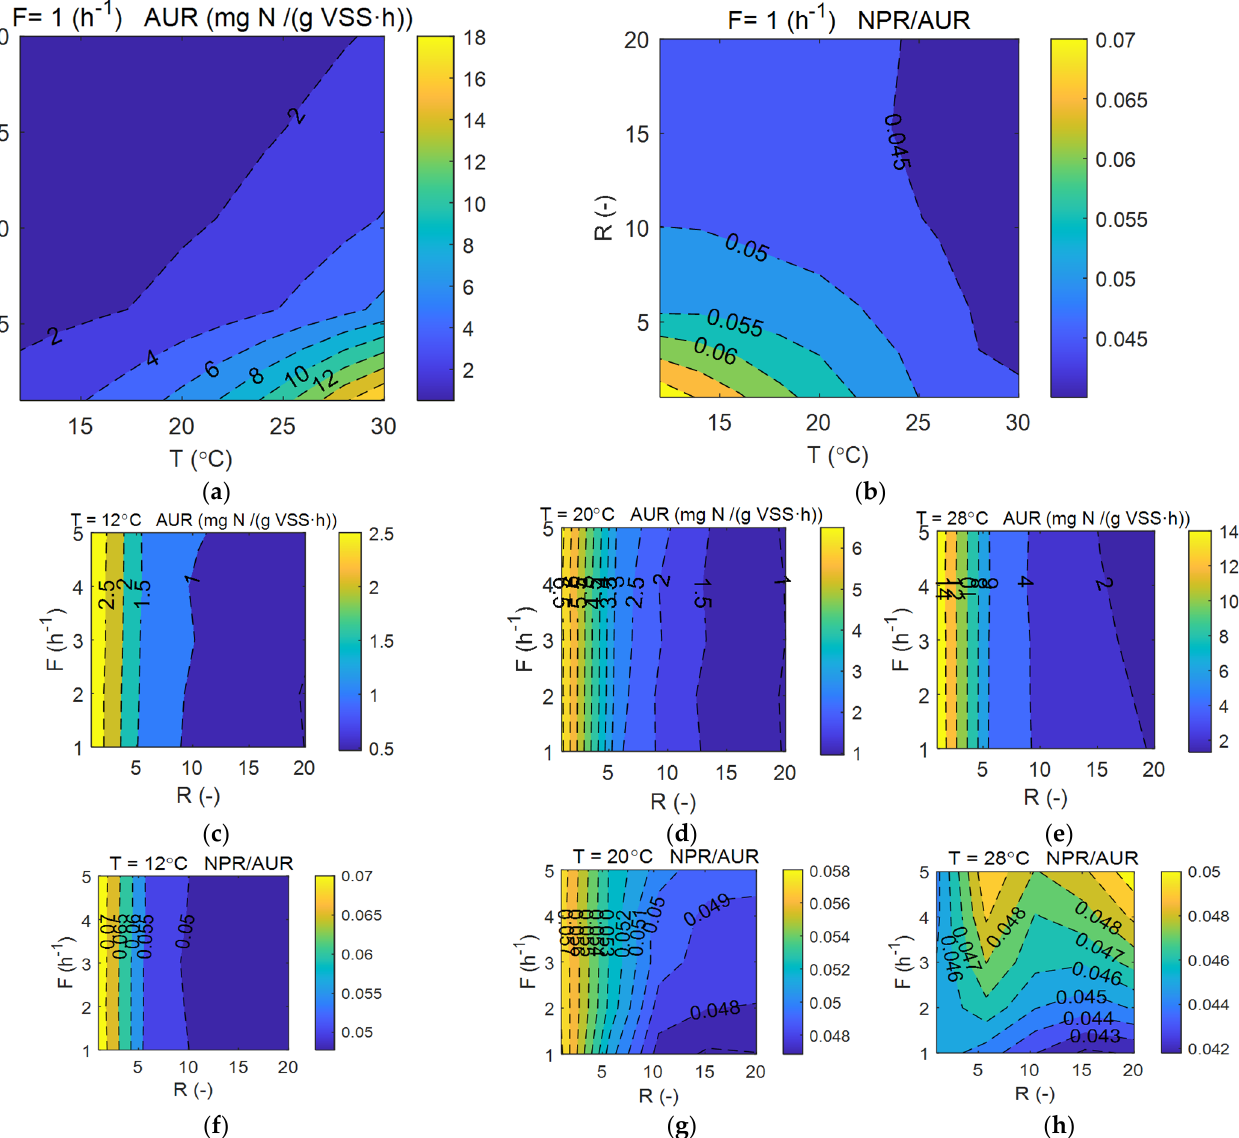
Figure 6. 2D response contour plots for the operational parameters of temperature and aeration strategy (F frequency, R ratio) on the AUR and NPR: the impact of the off/on ratio (R) and temperature on ( a ) AUR, ( b ) NPR/AUR at the fixed frequency (F) = 1 h −1 , the impact of frequency (F) and off/on ratio (R) ratio on ( c – e ) AUR and ( f – h ) NPR/AUR at different temperatures (12, 20, 28 °C)